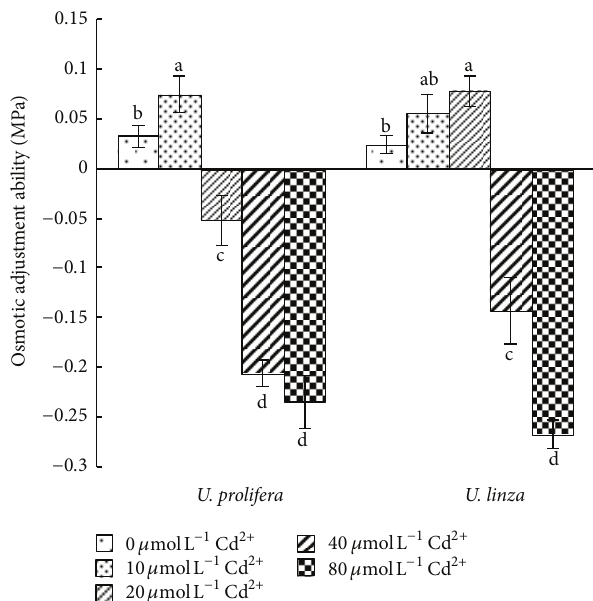
Figure 2: Effects of different concentrations of Cd 2+ (5, 10, 20, 40, and 80 𝜇 molL −1 ) on osmotic adjustment ability (OAA) of U. prolifera and U. linza.